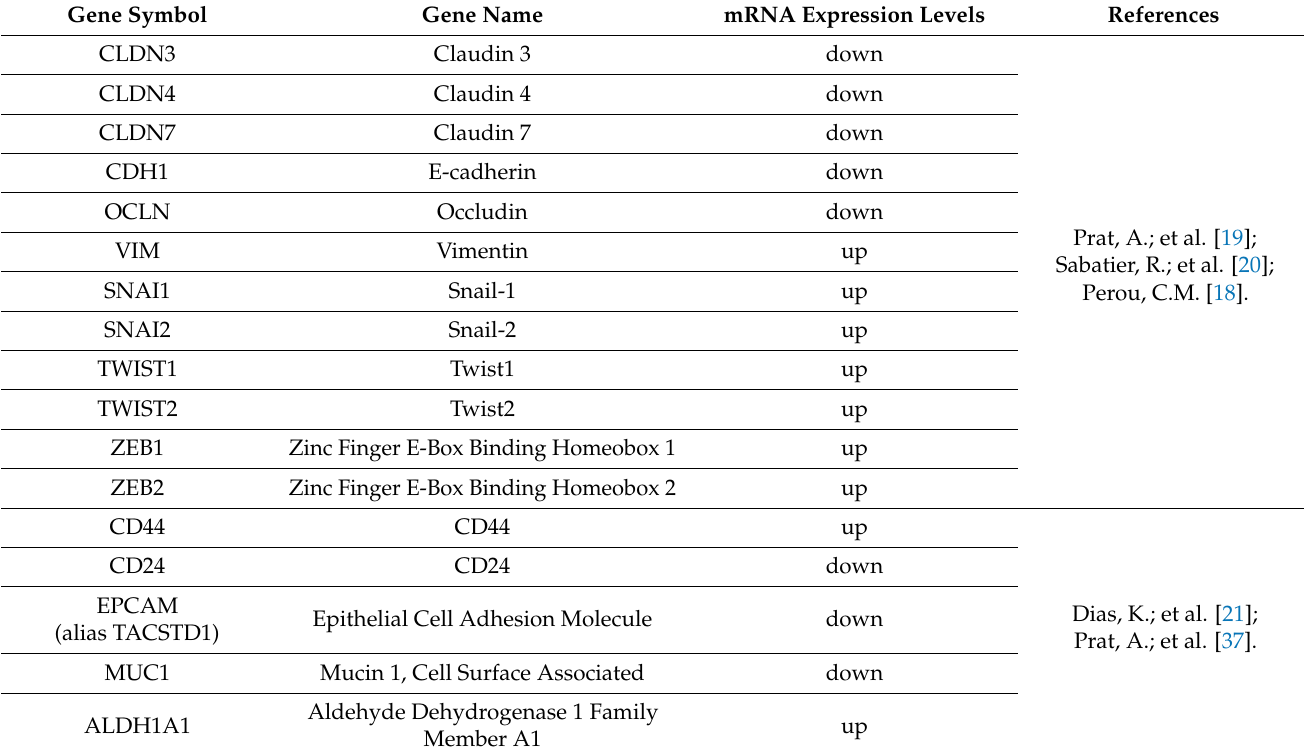
Table 2. Claudin low tumor marker